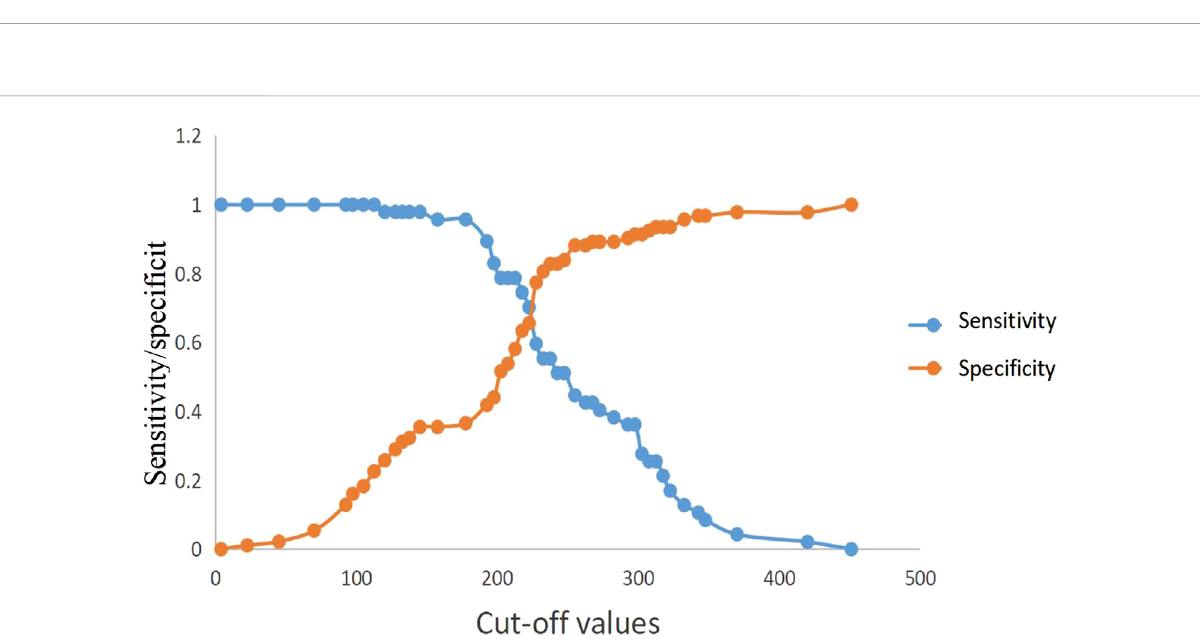
FIGURE 4 Predictive ef fi cacy for poor prognosis of clinical parameters of AP. AP: acute pancreatitis.